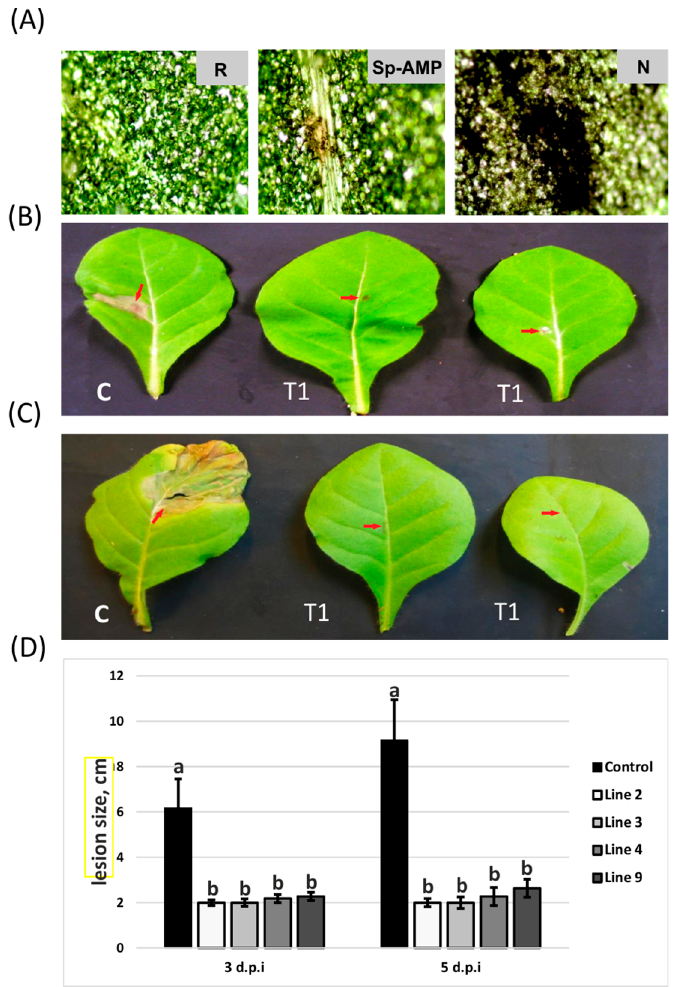
Figure 4. Disease evaluation in Sp ‐ AMP2 ‐ transgenic tobacco plants. ( A ) Left to right: leaf surface of non ‐ transgenic tobacco with no infection (R); spores inoculation symptoms caused by B. cinerea on a leaf surface of transgenic tobacco 3 days post ‐ inoculation (Sp ‐ AMP); spores inoculation symptoms caused by B. cinerea on a leaf surface of non ‐ transgenic tobacco 3 days post ‐ inoculation (N). ( B ) Size of lesions (indicated with red arrows) formed in leaves 3 days after inoculation with B. cinerea on wild type (C) and transgenic plants (T1). ( C ) Size of lesions progressed in leaves 5 days after inoculation with B. cinerea on the same plants. ( D ) Analysis of lesion sizes on transgenic lines T1 leaves overexpressing Sp ‐ AMP2 inoculated with B. cinerea compared to non ‐ transgenic T1 and wild type plants (control). Error bars indicate the standard error of the mean across three biological replicates. Letters indicate statistically significantly different groups identified by ANOVA analysis ( p < 0.001).